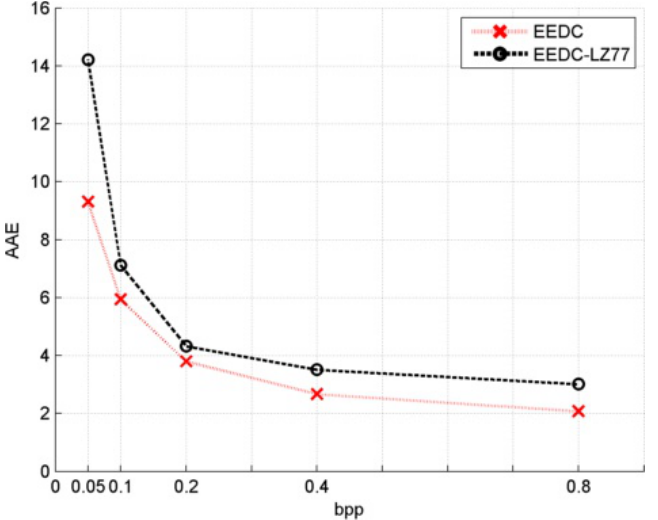
Figure 7. AAE for image horse and modified gray values compression with LZ77 coding.